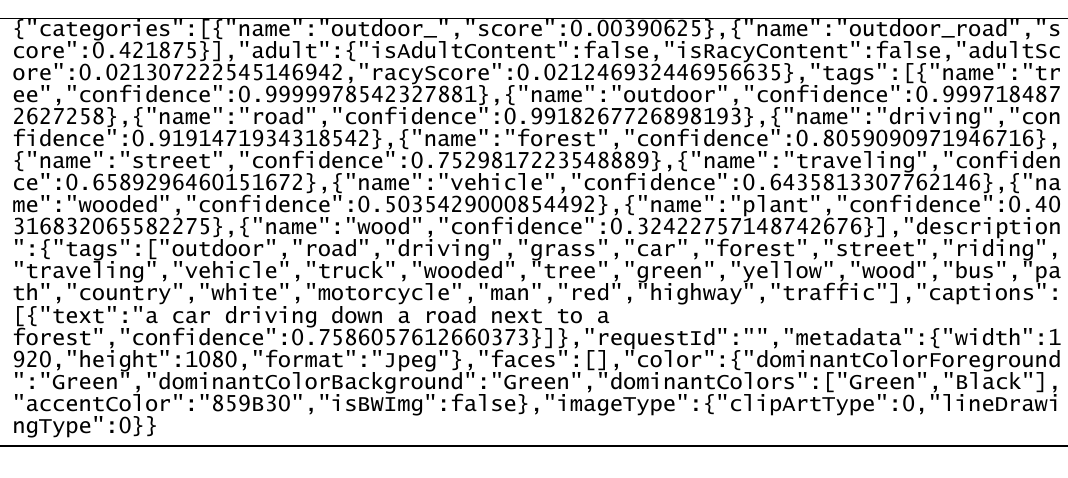
Figure 2. Sample image 2 and related API output.